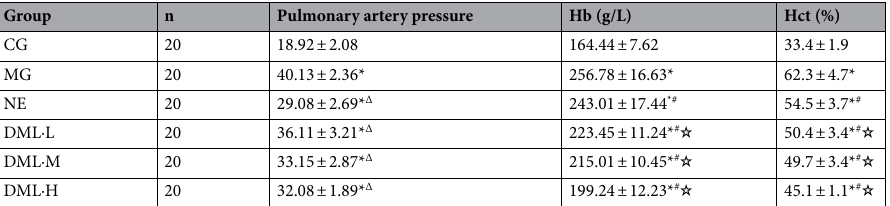
Table 1. The effects of DML treatment on pulmonary artery pressure, the serum levels of Hb, and the Hct, of rats in each group (mean ± D). Data are expressed as means ± standard deviation (n = 20 per group). Plain control group-CG; CMS group-MG; Nifedipine group-NE; Dracocephalum moldavica L. low dosage group- DML·L; Dracocephalum moldavica L. middle dosage group- DML·M; Dracocephalum moldavica L. high